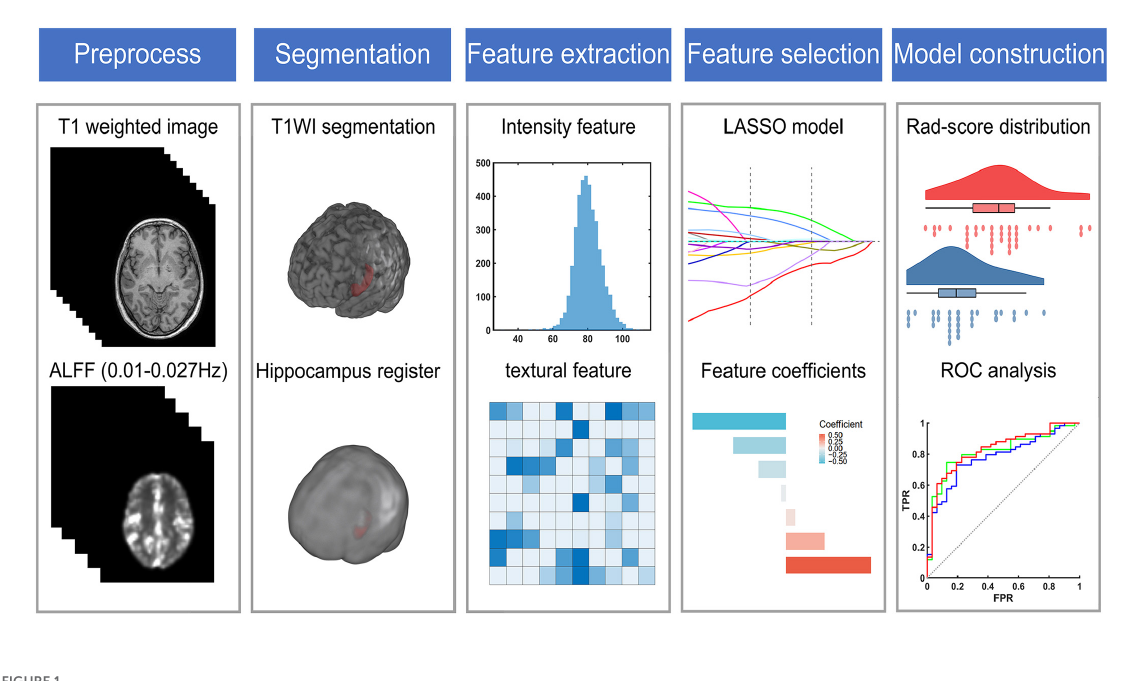
FOV = 220 × 220 mm 2 , flip angle = 90 ◦ , resolution = 64 × 64, and 210 volumes and 44